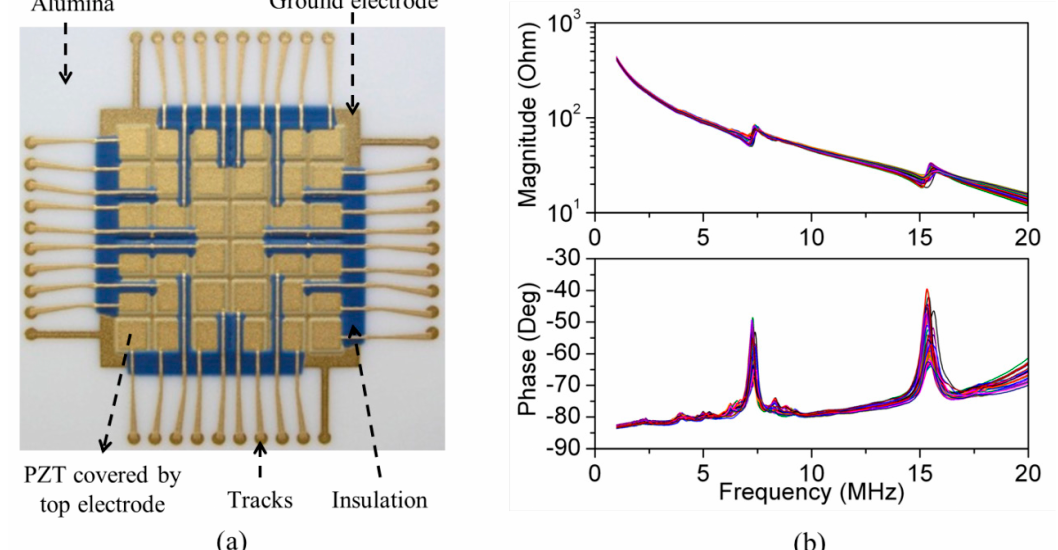
Figure 23. ( a ) PZT thick film 2-D matrix array; and ( b ) measured electrical impedance spectra of all 36